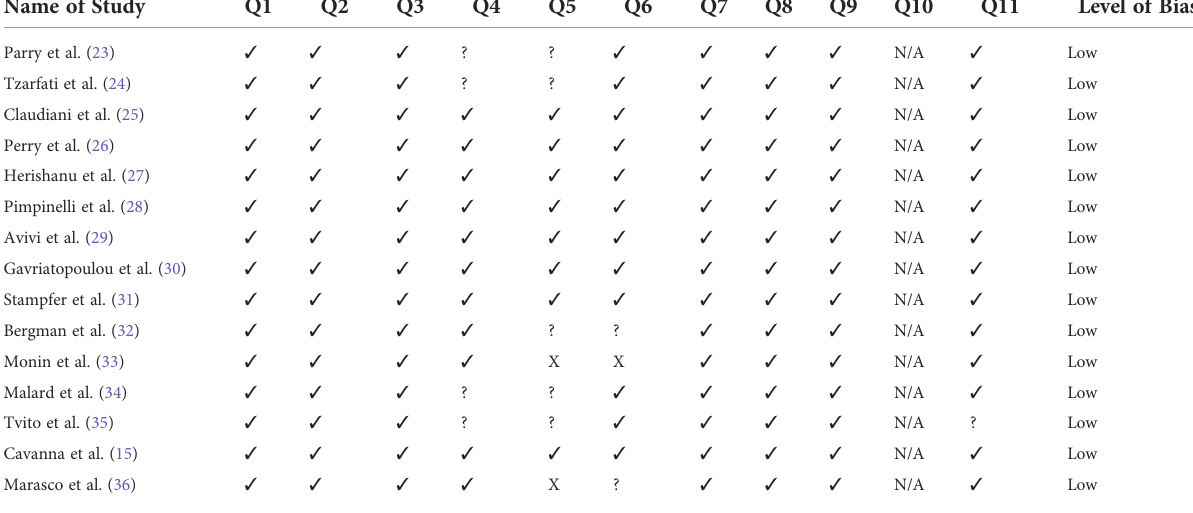
TABLE 3 Risk of bias assessment using the JBI checklist. Name of